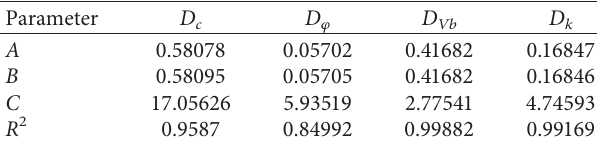
Table 4: Fitting parameters of antierosion ability parameter re- duction of the reinforced loess during F-T